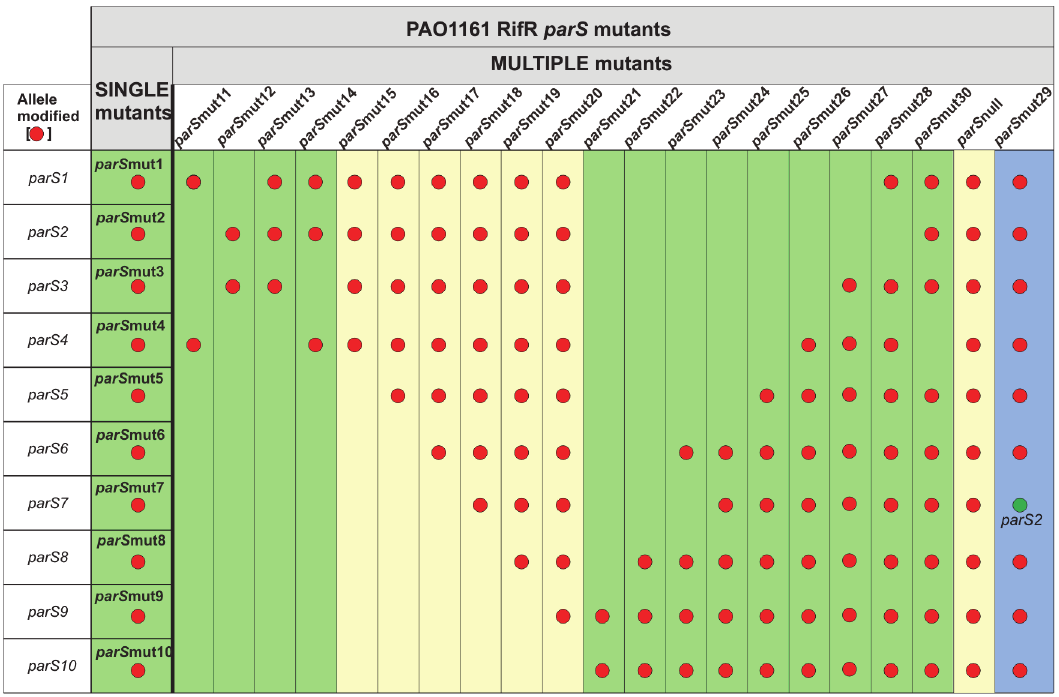
Fig 5. Summary of phenotypes of various parS mutants. The collection comprises 10 mutants with each individual parS modified (single) and 21 multiple mutants with between two and ten ( parS null ) parS sequences modified (red dots). Mutants in columns highlighted in green demonstrate wild-type phenotypes (wt-like), those highlighted in yellow show phenotypes similar to those observed for the parA null and parB null mutants ( parAB -like). The PAO1161 Rif R parS mut29 mutant has ectopic parS2 (green dot) replacing parS7 * in parS null mutant (highlighted in